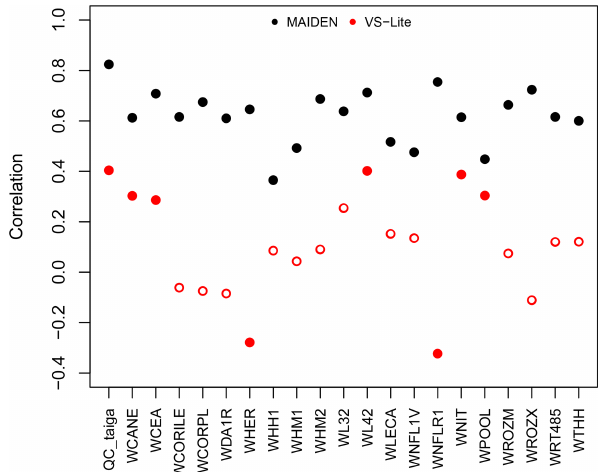
Figure 9. Pearson correlation coefficients between tree-growth observations and simulations at the Eastern Canadian taiga sites (Fig. 1a) with VS-Lite (in red) and MAIDEN (in black) using NR- CAN (5arcmin) as climatic inputs (Table 2) for the 1950–2000 cal- ibration period. White inner circles stand for non-significant corre- lations ( p value >